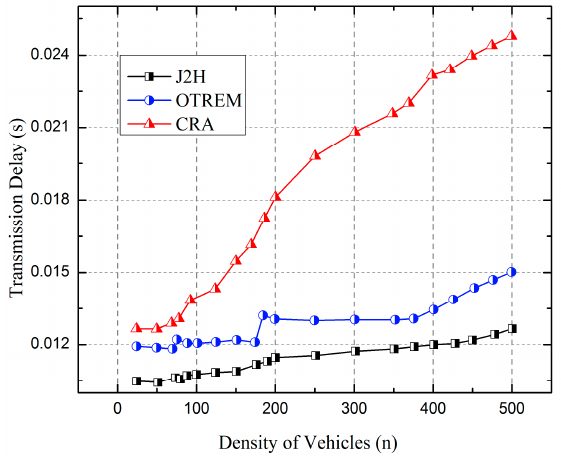
Figure 5. Analysis of transmission delay in transmitting alert messages with low density of vehi- cles.